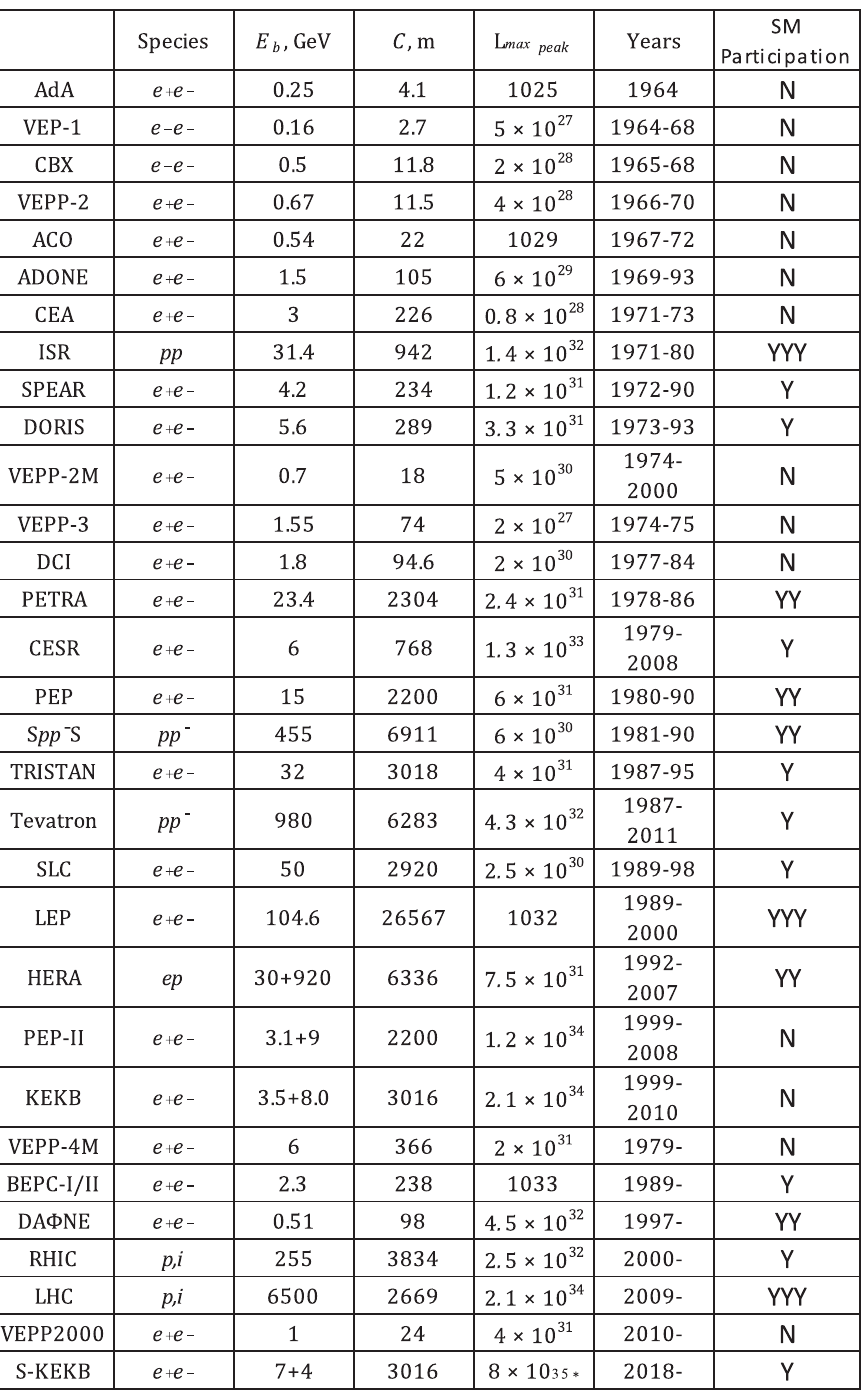
FIG. 4. Particle colliders from Shiltsev and Zimmermann: